Question: Provide a one-line summary of what is displayed.
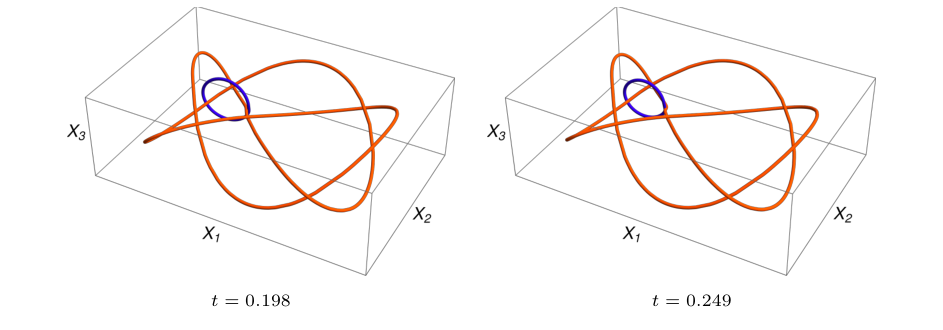
Answer: 2. The Listing’s 8-knot curve linked with a circle a) and an ellipse b)